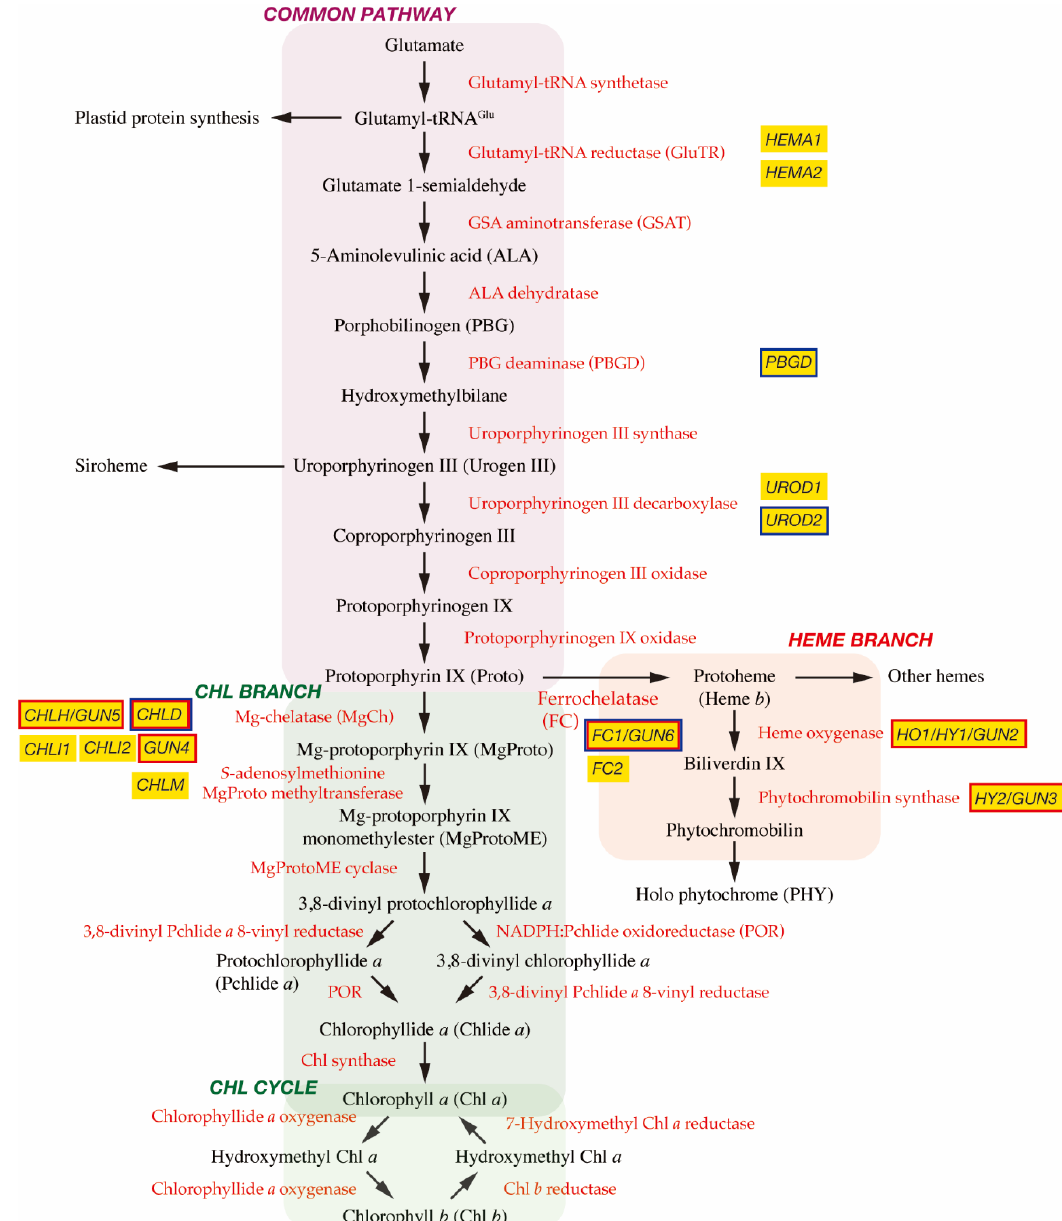
Figure 1. Tetrapyrrole biosynthetic pathway. Enzymes involved in the tetrapyrrole biosynthetic pathway are indicated by red. Important genes described in this article are shown in yellow boxes and genes encoding GUN proteins are indicated by red borders. It is noted that GUN2 ~ GUN6 genes are found at the branch points of Chl and heme biosynthesis. GUN1 interacting proteins are indicated by blue